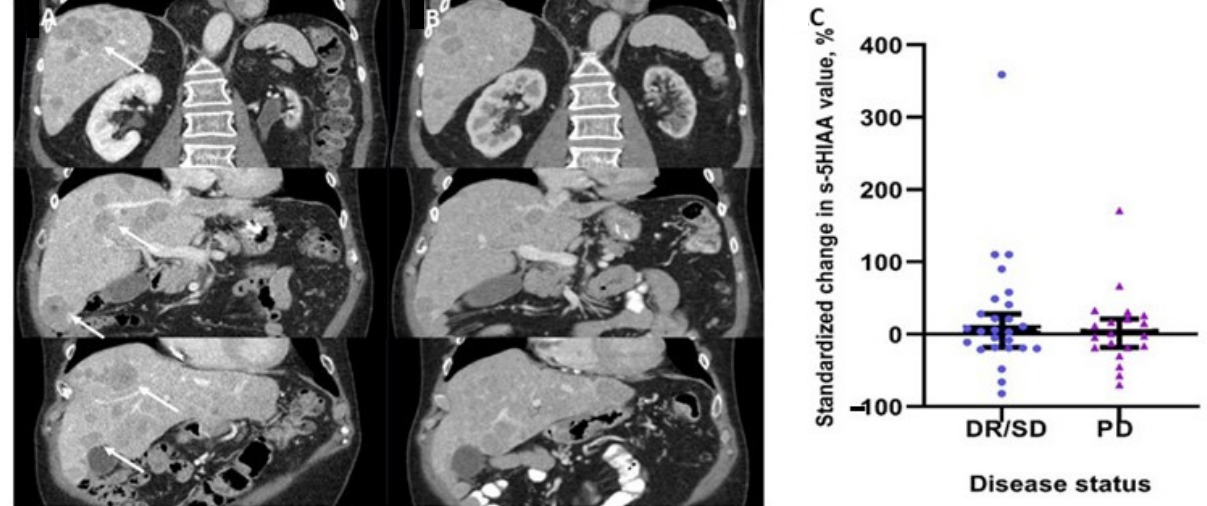
Figure 1. ( A ) Patient with small intestinal neuroendocrine neoplasm (SI-NEN). Liver metastases on coronary plane with evident progression (white arrows) according to RECIST 1.1, as compared to ( B ): CT examination of the same patient performed 5 months earlier. ( C ) Scatter plot of the standardized change in serum 5-hydroxyinoloacetic acid (5HIAA) (median with 95% CIs) in relation to disease progression ( p = 0.673). Serum 5HIAA values were obtained concurrently to matched CT/MRI examinations to access disease status according to RECIST 1.1. Abbreviations. DR: Disease Regression; PD: Progressive Disease; RECIST: Response evaluation criteria in solid tumors; SD: Stable Disease.